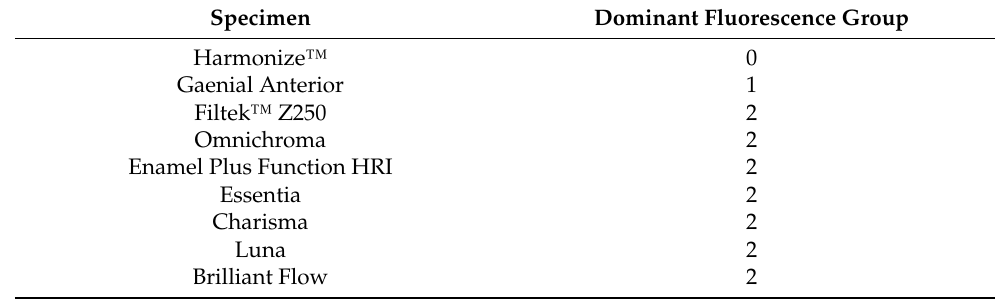
Figure 4. Column graph of the fluorescence intensity values (in arbitrary units) measured after 6 months, representing the mean and standard deviation (SD) of each type of composite and the enamel. Table 3. The final values provided by the evaluators according to the defined fluorescence Table 2. Reduction of the fluorescence intensity values after the second measurement for each ma- terial and the enamel specimens; p values are based on Mann–Whitney nonparametric tests.